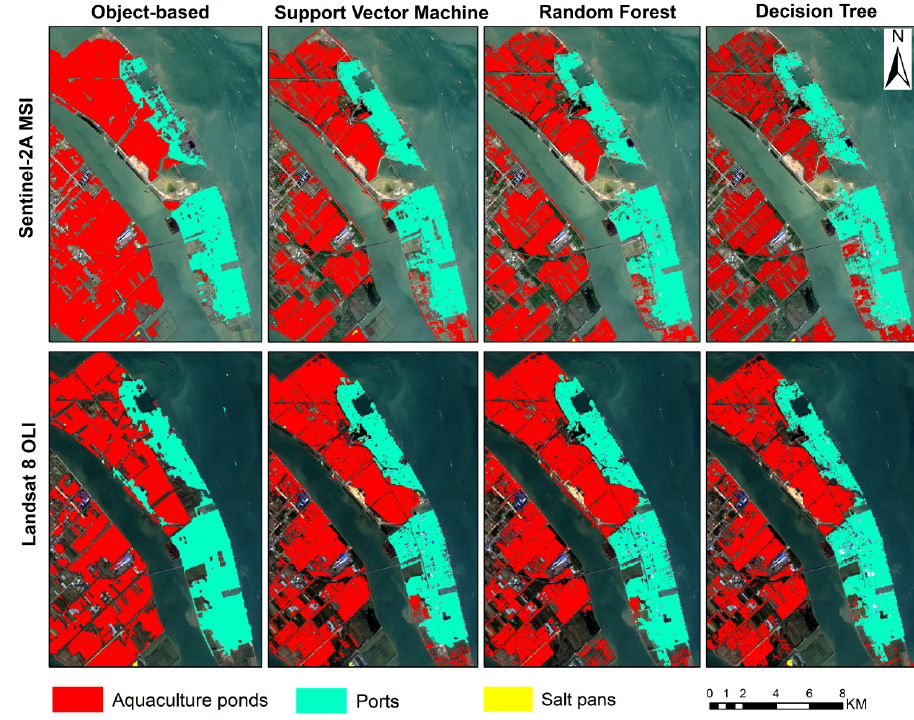
Figure 5. Classification of the reclamation uses from the four classifiers in the Pearl River Delta.